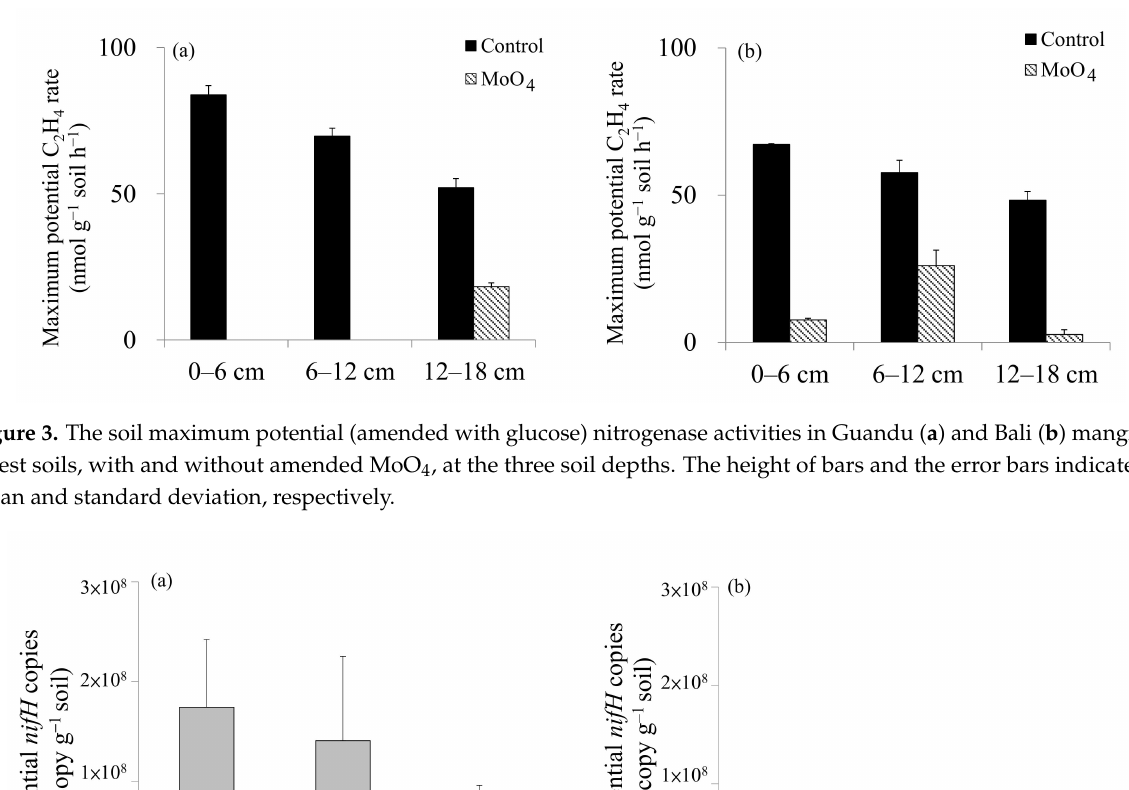
Figure 2. The soil potential nitrogenase activities in Guandu ( a ) and Bali ( b ) mangrove forest soils at the three soil depths. The height of bars and the error bars indicate the mean and standard deviation, respectively.